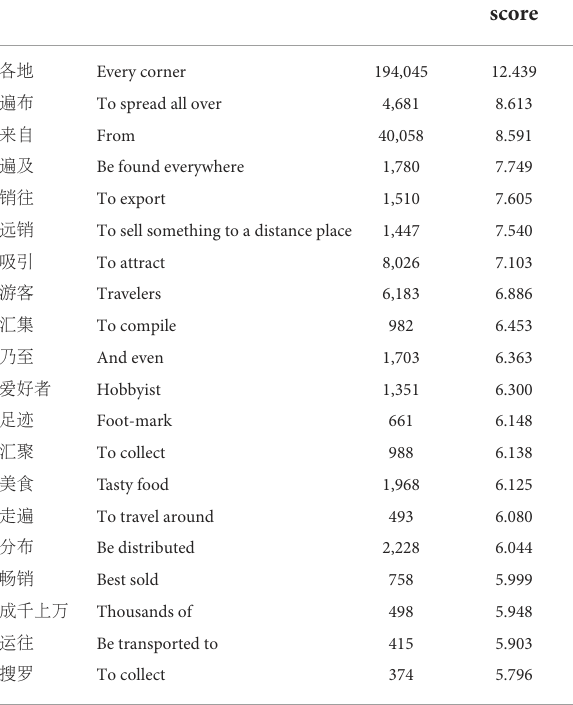
TABLE 9 The collocates of 世 界 各 地 shi4jie4ge4di4 (every corner of the world) within a four-word span. Collocates Frequency LogDice